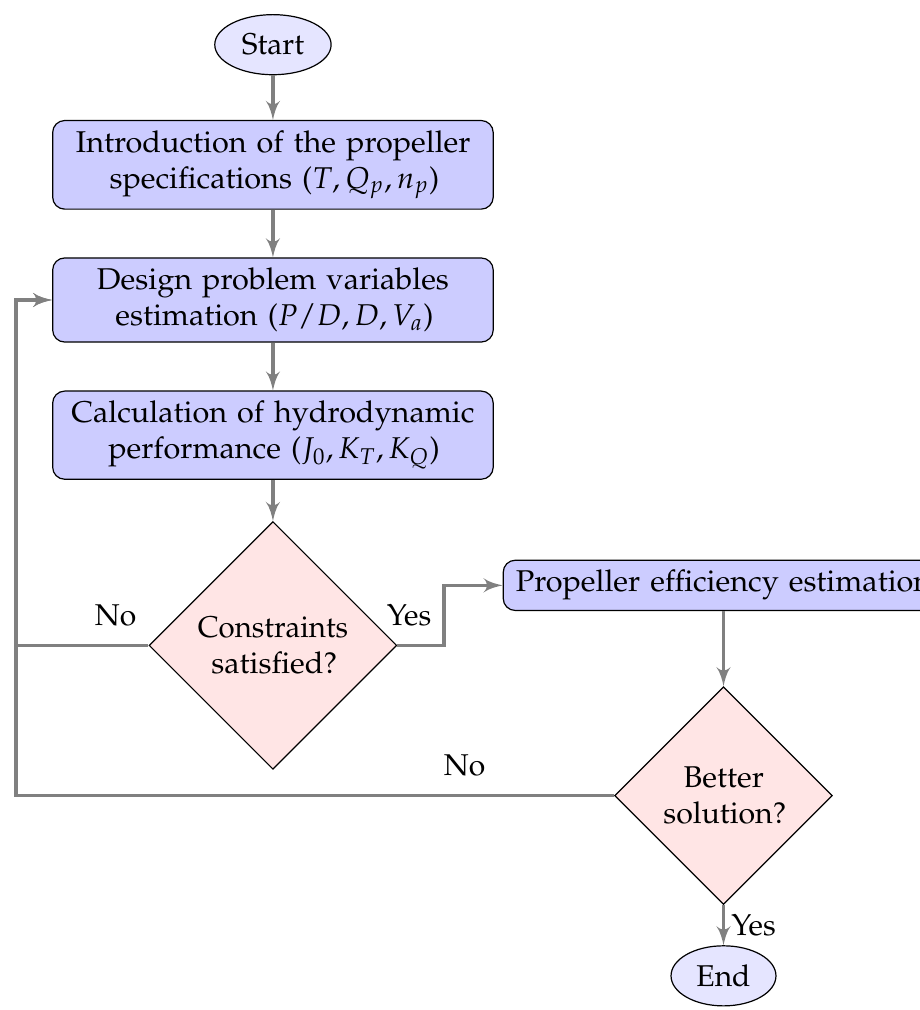
Figure 3. Propeller design and optimization procedure flowchart.